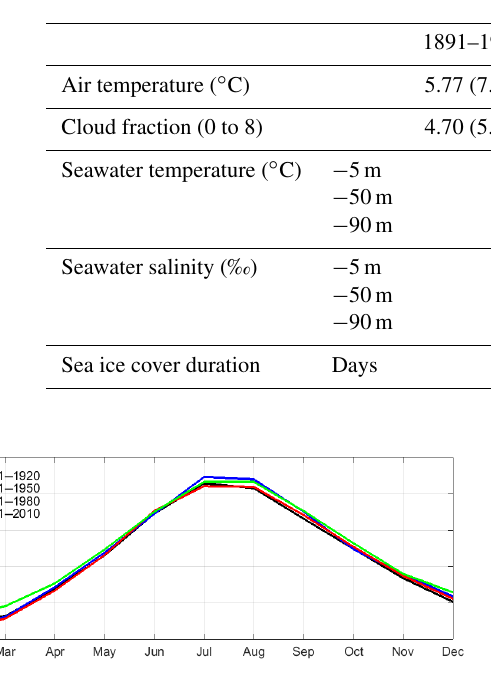
Table 1. Average values with standard deviations for the 30-year periods of 1891–1920, 1921–1950, 1951–1980 and 1981–2010. As there have been gaps in observations, the uncertainties between variables and periods vary. Due to the limited amount of hydrographic and sea ice data during the first period (1891–1920), only values for air temperature and cloud fraction are shown.